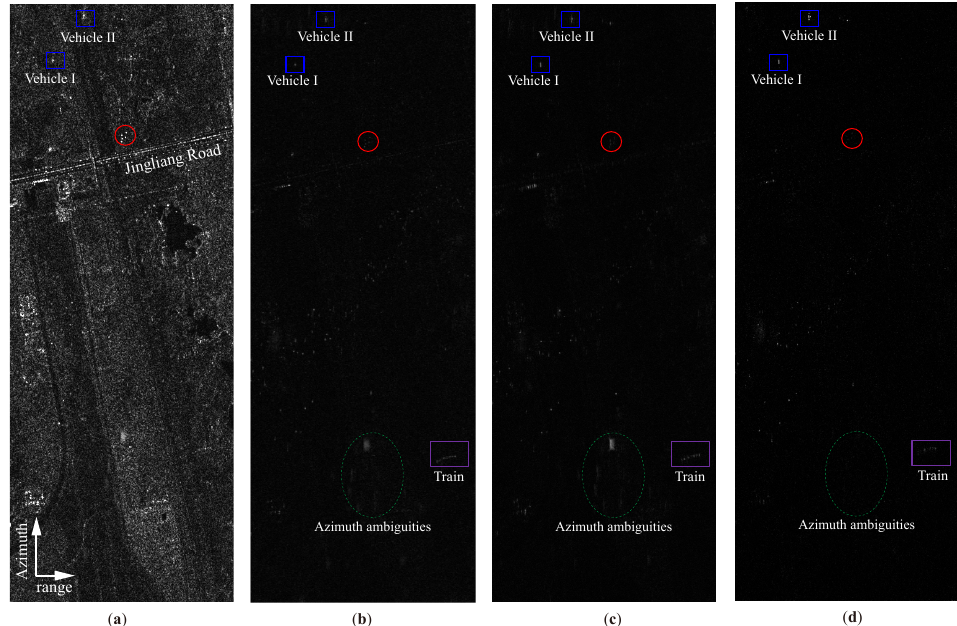
Figure 14. Experimental results and comparisons, ( a ) the imaging result from the original SAR data, and selected location of this experiment (the Jingliang Road), the corner reflectors on the ground, which are marked by a red circle, and the two moving vehicles, ( b ) the conventional DPCA result based on the original SAR data, ( c ) the clutter suppression result by the Deramp-STAP based on the subsampled data, and ( d ) the clutter suppression result (after the second layer of channel cancellation) by the proposed algorithm based on the subsampled